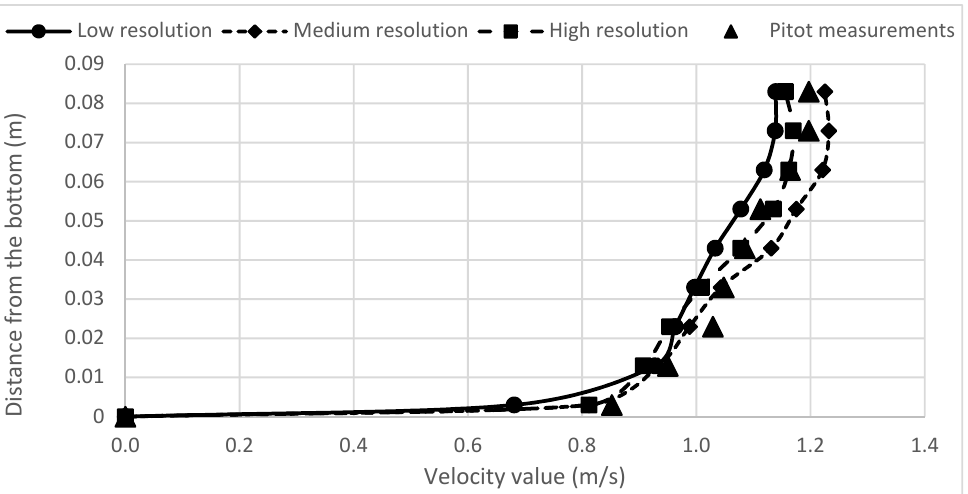
Figure 14. Comparison between the velocity profiles reconstructed with Model #2 at three different resolutions and Pitot measurements at location 0.14 m upstream from the chute and within the surface spillway volume.